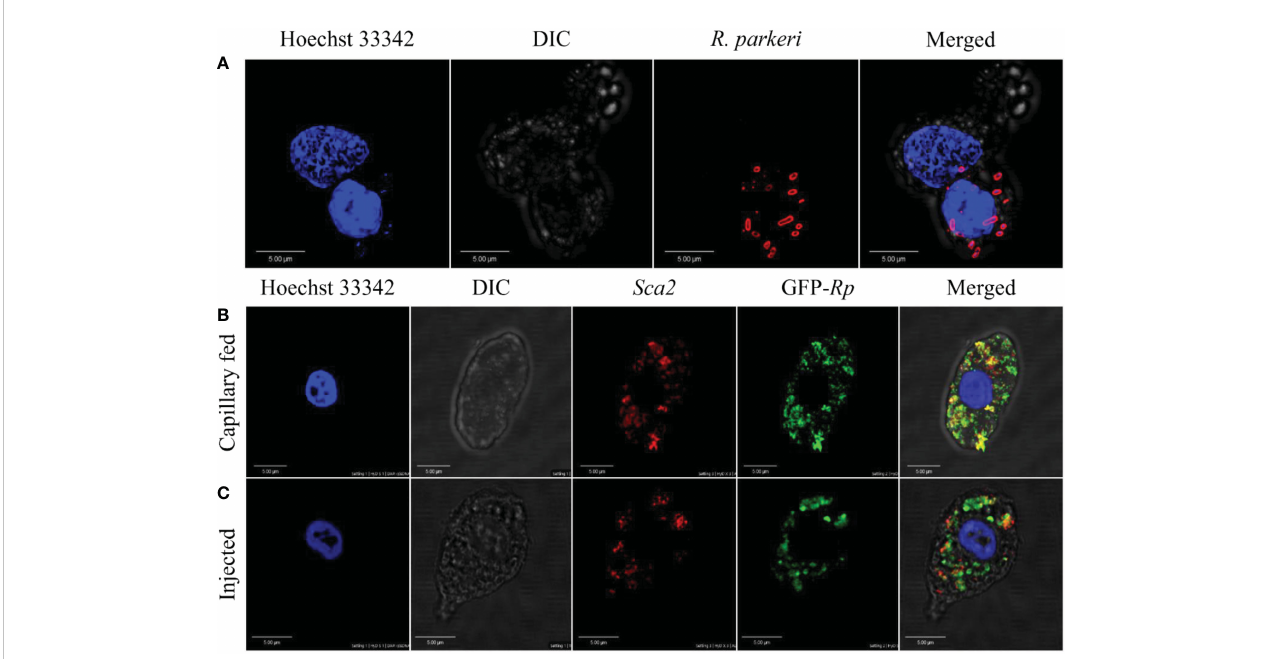
FIGURE 5 Confocal microscopy images of phagocytic hemocytes infected with Rickettsia parkeri . Representative confocal images of immuno fl uorescence staining for R. parkeri proteins showing hemocytes from natural and arti fi cially infected ticks. (A) Immunolocalization of R. parkeri in hemocytes of naturally infected Am. maculatum . Hemocytes were incubated with primary antibodies targeting R. parkeri outer membrane protein (red) and Hoechst 33342 (blue). Infection of hemocytes with R. parkeri following (B) capillary feeding and (C) microinjection of GFP-expressing R. parkeri into uninfected Am. maculatum . Hemocytes were incubated with R. parkeri Sca2 antibody (red) and Hoechst 33342 (blue). Hemocytes were fi xed, permeabilized and blocked prior to incubating with antibody. Scale bar = 5 m m.